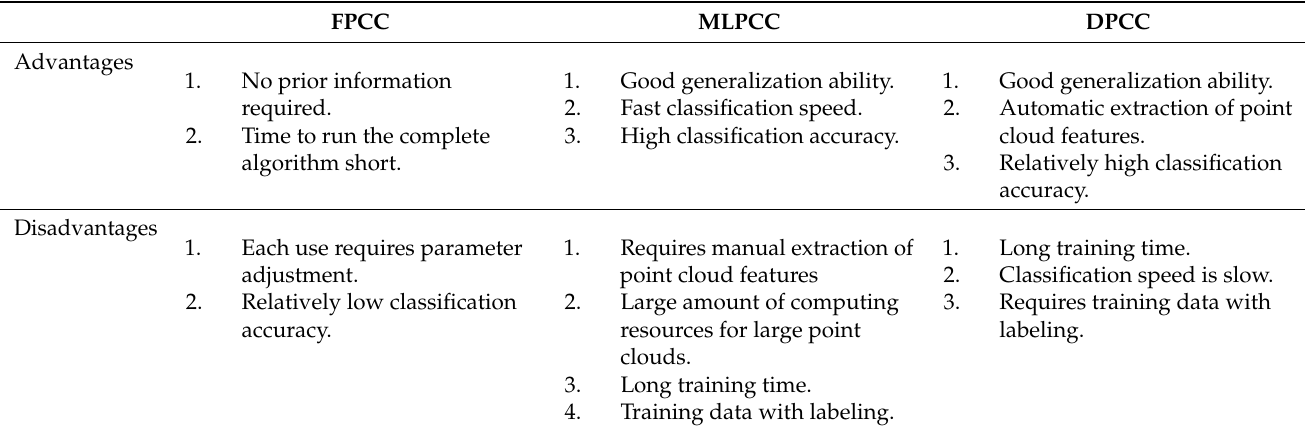
Table 7. Advantages and disadvantages of different